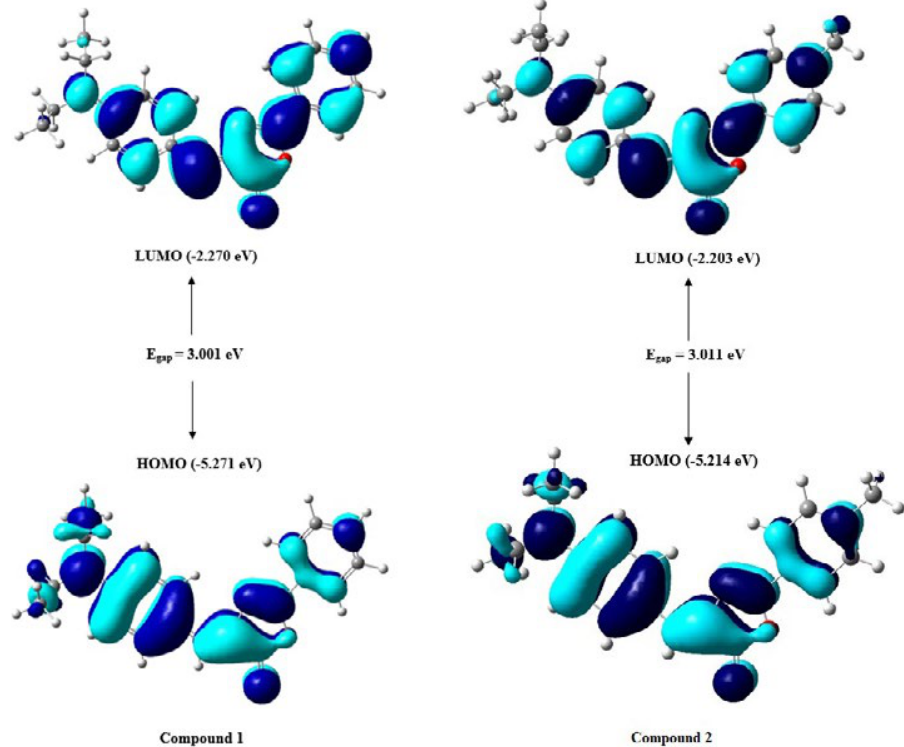
Figure 4. Frontier molecular orbital surfaces and energy levels for the HOMO and LUMO of the compounds 1 and 2 computed at B3LYP/6-311G(d,p) level.